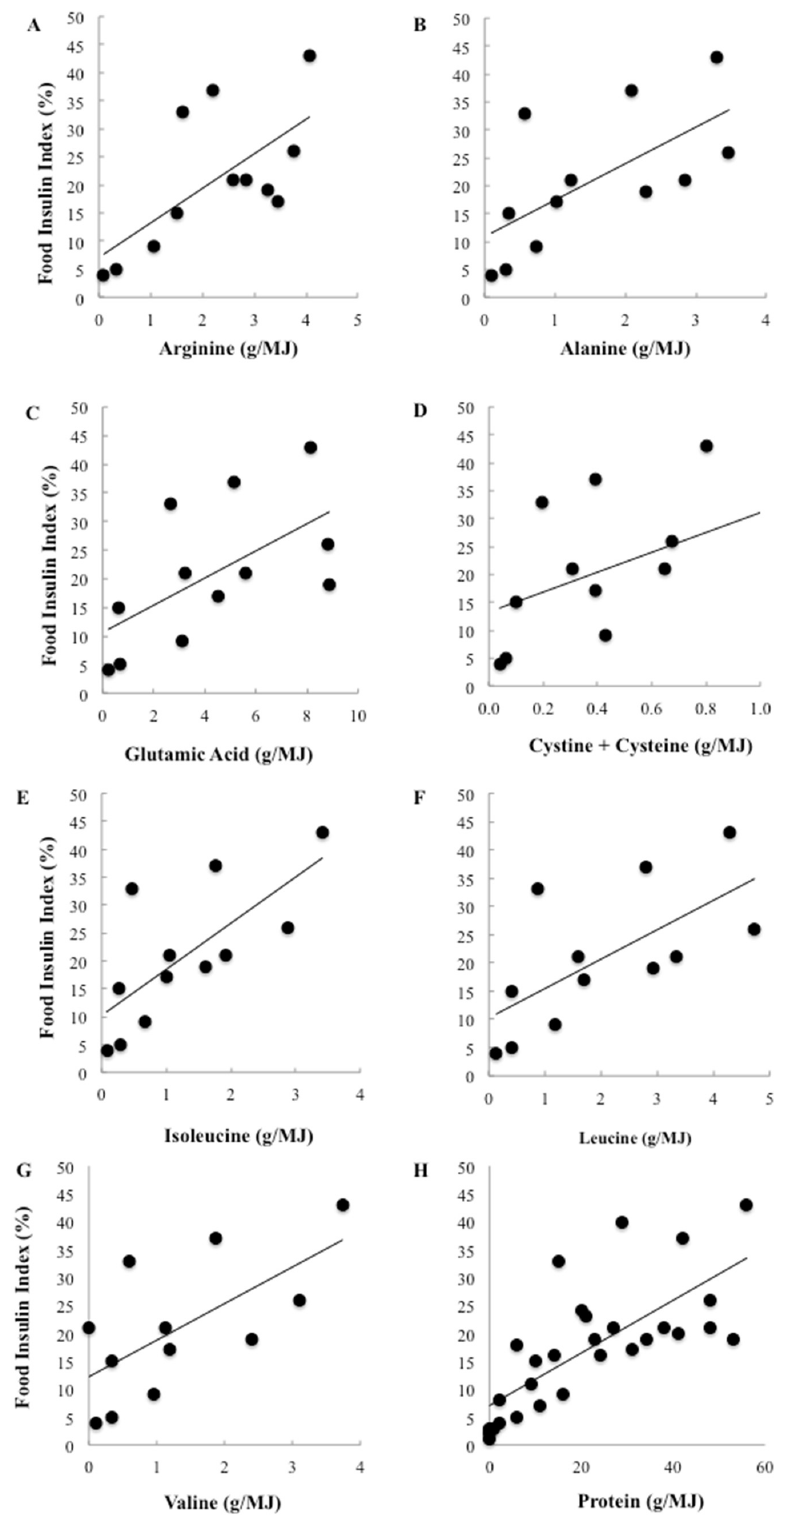
Figure 4. ( A – G ) Univariate correlations between the food insulin index and alanine, glutamic acid, arginine, cystine + cysteine, leucine, isoleucine and valine for 1000 kJ portions of single foods containing at least 10 g of available carbohydrate ( A – G : n = 12, H : n =